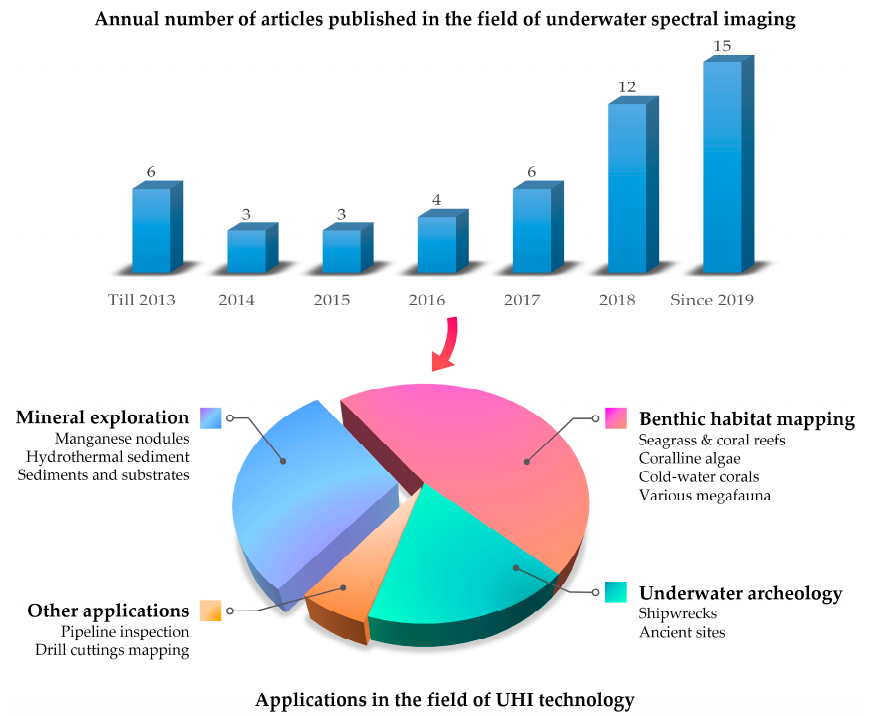
Figure 8. The development trend of underwater spectral imaging technology. Top picture: Statistics on the number of articles in the field of underwater spectral imaging technology in recent years. Bottom picture: Current applications in the field of UHI technology. Table 4. Comparison of different architectures of the underwater spectral imaging system. LCTF: liquid crystal tunable filter.